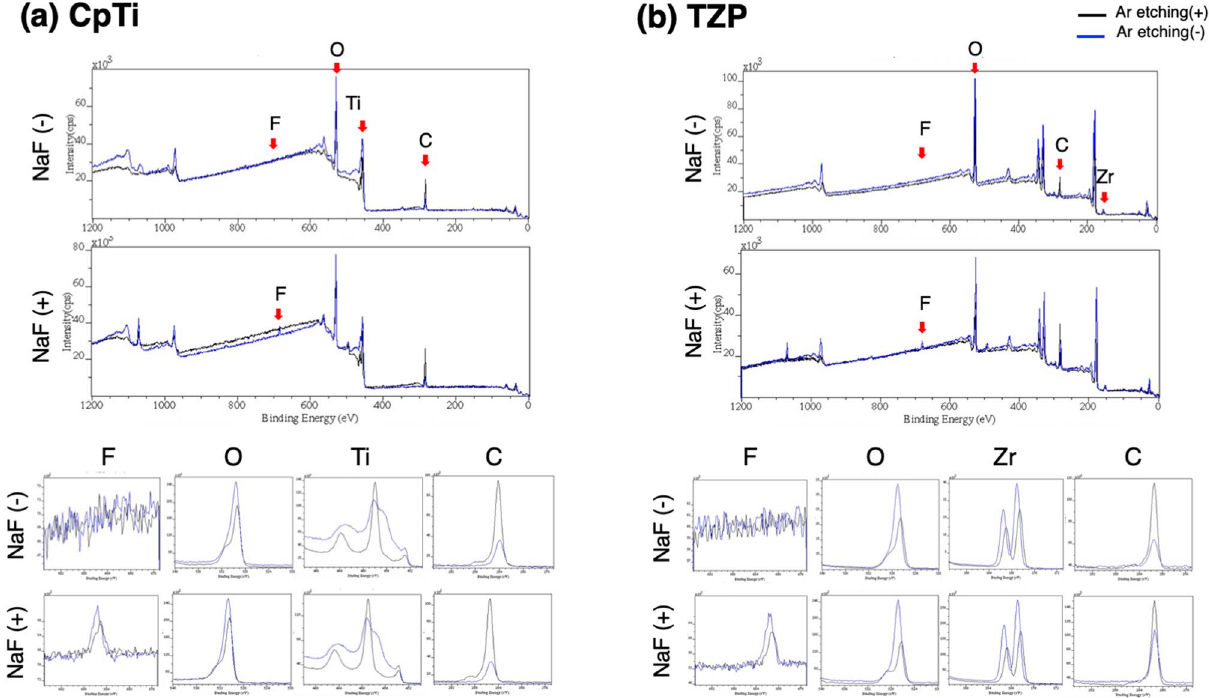
Figure 1. Use of XPS in the analysis of CpTi ( a ) and TZP ( b ). XPS was used to analyze up to a depth of 1 nm from the surface and another 1 nm from the surface with Ar etching. ( a , b ) In both CpTi and TZP, F was detected on NaF (+) surfaces, but not in NaF (−) surfaces. With or without Ar etching, F was detected in NaF (+) surfaces, but not in NaF (−) surfaces. The intensity of C decreased, and that of O increased with Ar etching. CasaXPS software version2.3.23 was used (http://www.casax